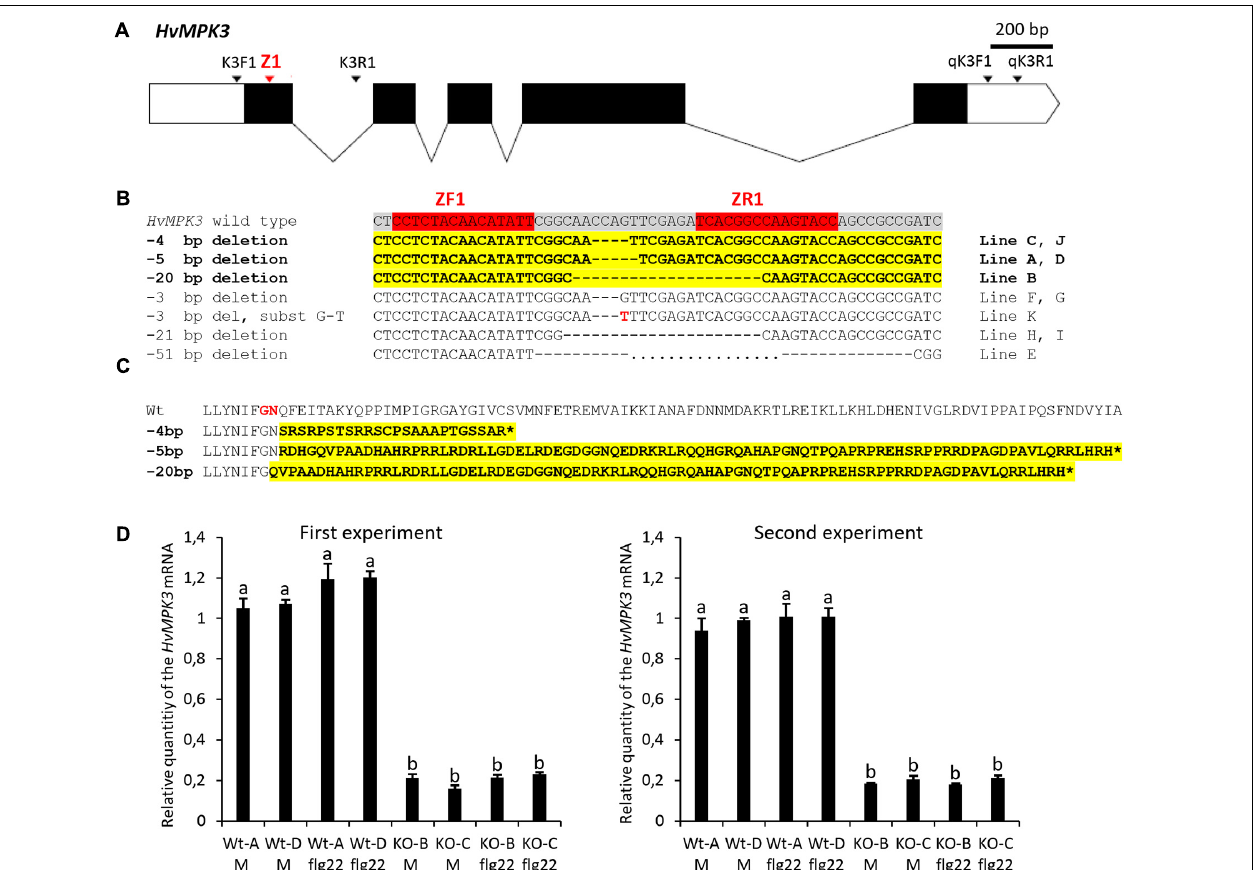
FIGURE 1 | Development and characterization of the homozygous HvMPK3 knock-out (KO) barley lines. (A) Schematic representation of the transcribed portion of the HvMPK3 gene (HORVU4Hr1G057200, Ensembl Plants, http://plants.ensembl.org/index.html). HORVU4Hr1G057200.4 splicing variant coding for the 369 amino acid long HvMPK3 protein is depicted. Coding exons are shown as black rectangles and 5 (cid:48) and 3 (cid:48) untranslated regions are shown as open rectangles. Introns are indicated by solid lines. Binding sites of the Z1 TALEN pair are indicated by red arrowhead in the coding region of the first exon (Ex1). Annealing positions of the K3F1/K3R1 primers (mutation genotyping) and of the qK3F1/qK3R1 primers (RT-qPCR) are indicated by black arrowheads. (B) Z1 TALEN pair-induced mutations observed in 11 independent lines in T1 generation. Red boxes in the wild type HvMKP3 sequence indicate binding sites of the ZF1 and ZR1 monomers of the Z1 TALEN pair. Black dashes indicate the identified deletions. The size of the deletion is shown on the left of each mutated sequence. Transgenic lines indicated on the right of each mutated sequence were homozygous for the respective mutations in the T1 generation. Sequences harboring frame-shift (loss-of-function) mutations are shown in bolt and highlighted in yellow. Also, the respective designations of the deletion sizes and lines are shown in bolt. (C) Putative truncated versions of the HvMPK3 protein associated with the Z1 TALEN pair-induced loss-of-function mutations. Reference wild type HORVU4Hr1G057200.4 HvMPK3 protein and its truncated versions are translated from the nucleotide sequences starting two base pair upstream of the ZR1 TALEN binding site. The size of the respective loss-of-function deletion is shown on the left of each truncated HvMPK3 protein. Aberrant peptide sequences resulting from frameshift translations are shown in bolt and highlighted in yellow. The frameshift occurs after decoding of the 26th codon (–20 bp deletion) or 27th codon (–4 and –5 bp deletions) in the HORVU4Hr1G057200.4 HvMPK3 gene. Amino acids coded by the 26th codon and 27th codon of the gene are shown in red in the wild-type HvMPK3 sequence. Translation termination at premature stop codon is indicated by asterisk. (D) Relative quantity of the HvMPK3 mRNA in the roots of the HvMPK3 KO and control barley lines. Four days old intact seedlings of the HvMPK3 KO lines HvMPK3 KO-B (KO-B) and HvMPK3 KO-C (KO-C) and wild type control lines A (WT-A) and D (WT-D) were incubated in liquid Fåhreus medium with nitrogen (FAH) (M – mock treatment) or in liquid FAH medium supplemented with 1 µ M flg22 (flg22 – flg22 treatment) in two biological replicates for 6 h. The expression of the HvMPK3 gene was normalized to the expression of the reference HvMPK14 gene and is shown as relative to the single biological replicate of the WT-A Mock sample. An average value of two biological replicates is plotted per each genotype/treatment combination. Error bars indicate standard deviations from two biological replicates. Data were analyzed by one-way ANOVA with the Tukey’s Post hoc test. Means with different letters are significantly different at P < 0.01. Experiment was repeated two times with similar results (First and Second